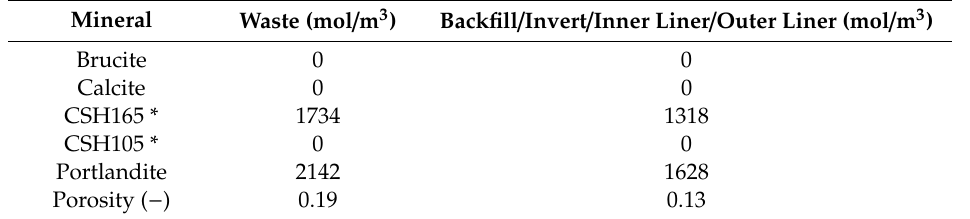
Table 2. Water compositions. The external water is based on a calcite-equilibrated calculation with FRHP water [31] and the initial porewater is equilibrated with the cement material for Backfill (Table 1).